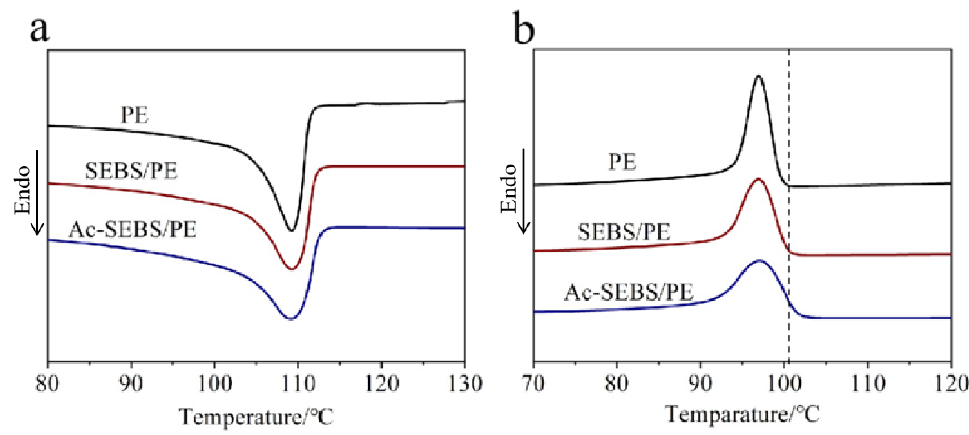
Figure 4. ( a ) Melting curves and ( b ) crystallization curves of PE, SEBS / PE, and Ac-SEBS / PE. Table 1. Summary of Differential Scanning Calorimetry (DSC) data of PE, SEBS/PE, and Ac- SEBS/PE.